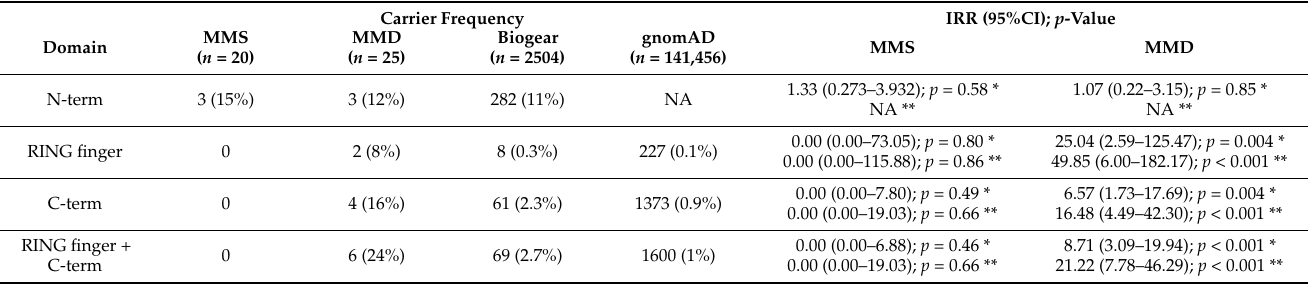
Table 5. Putatively damaging RNF213 rare variants burden